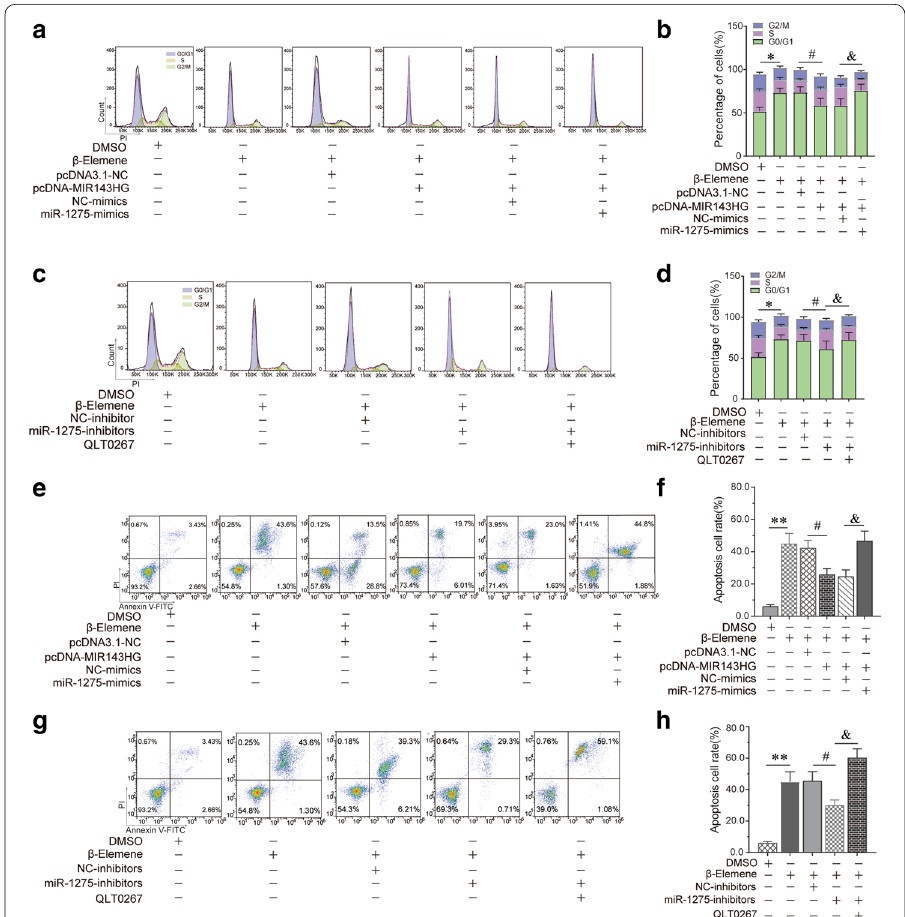
Fig. 6 β-Elemene induced PHAGF G0/G1-phase arrest and apoptosis via MIR143HG/miR-1275/ILK axis. a – d Cell cycle distributions in PHAF, PHAGF and PHAGF under indicated treatments were analyzed by flow cytometry, and their corresponding statistical graphs were presented (comparing the rate of cell-cycle arrest in G0/G1-phase). e – h Apoptosis in PHAF, PHAGF and PHAGF under indicated treatments was analyzed by flow cytometry, and their corresponding statistical graphs were presented (comparing the relative amount of early apoptosis plus late apoptosis). * P < 0.05; ** P < 0.01; # P < 0.05; ## P < 0.01; & P <